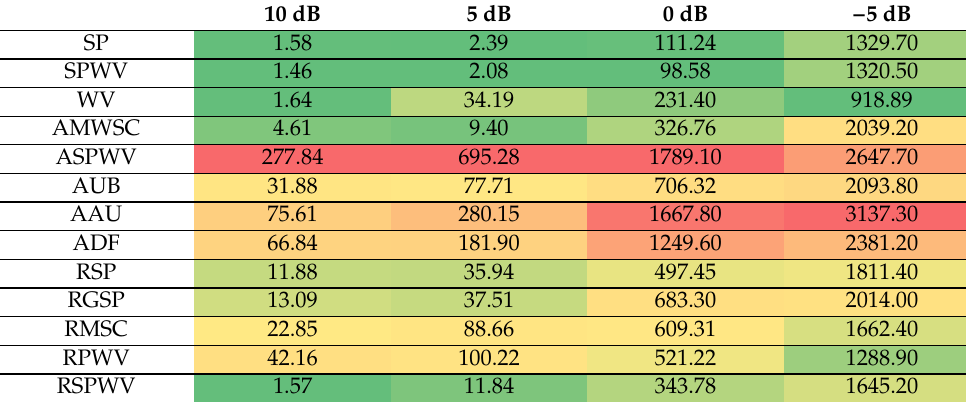
Table 1. Estimation of IF MSE for noisy mono-component linear FM signal for different SNR levels (averaged over 100 noise realizations), cell colors range from green for the best result to red for the worst result in each column respectively, 1 × 10 − 5 .